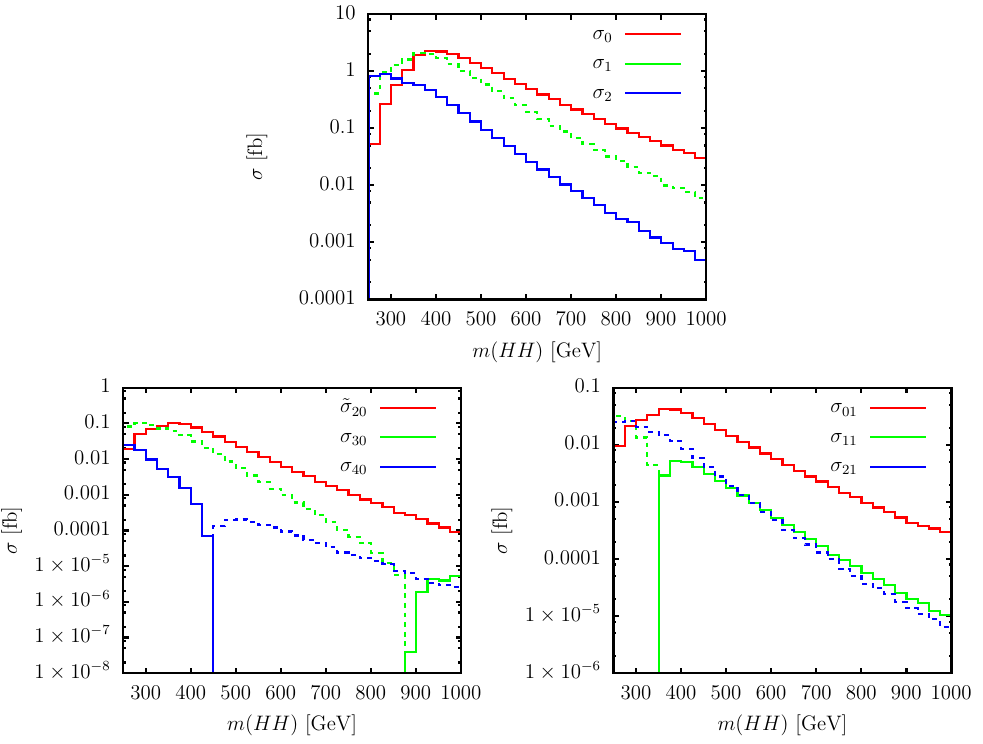
Figure 7 . Individual (cid:27) contributions to (cid:27) LO , while the lower plots those to (cid:1) (cid:27) (cid:22) c